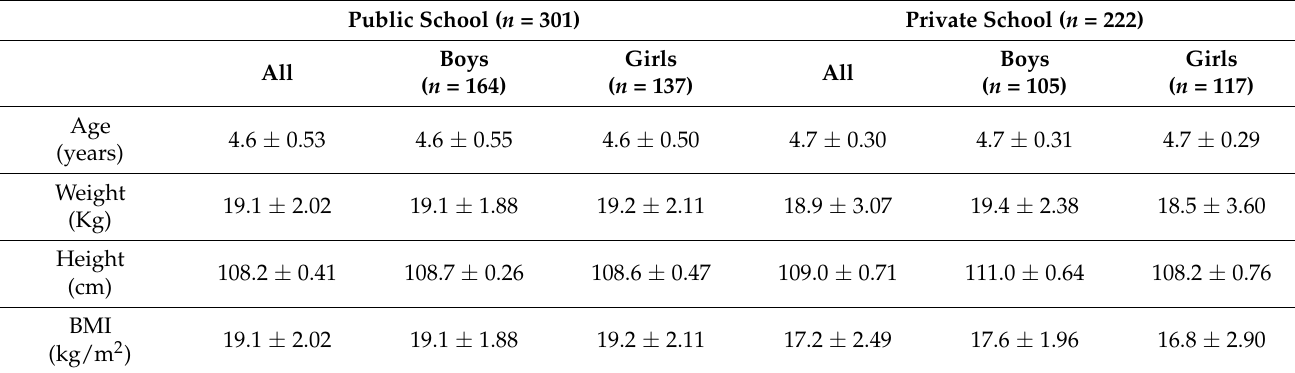
Table 2. Baseline characteristics of